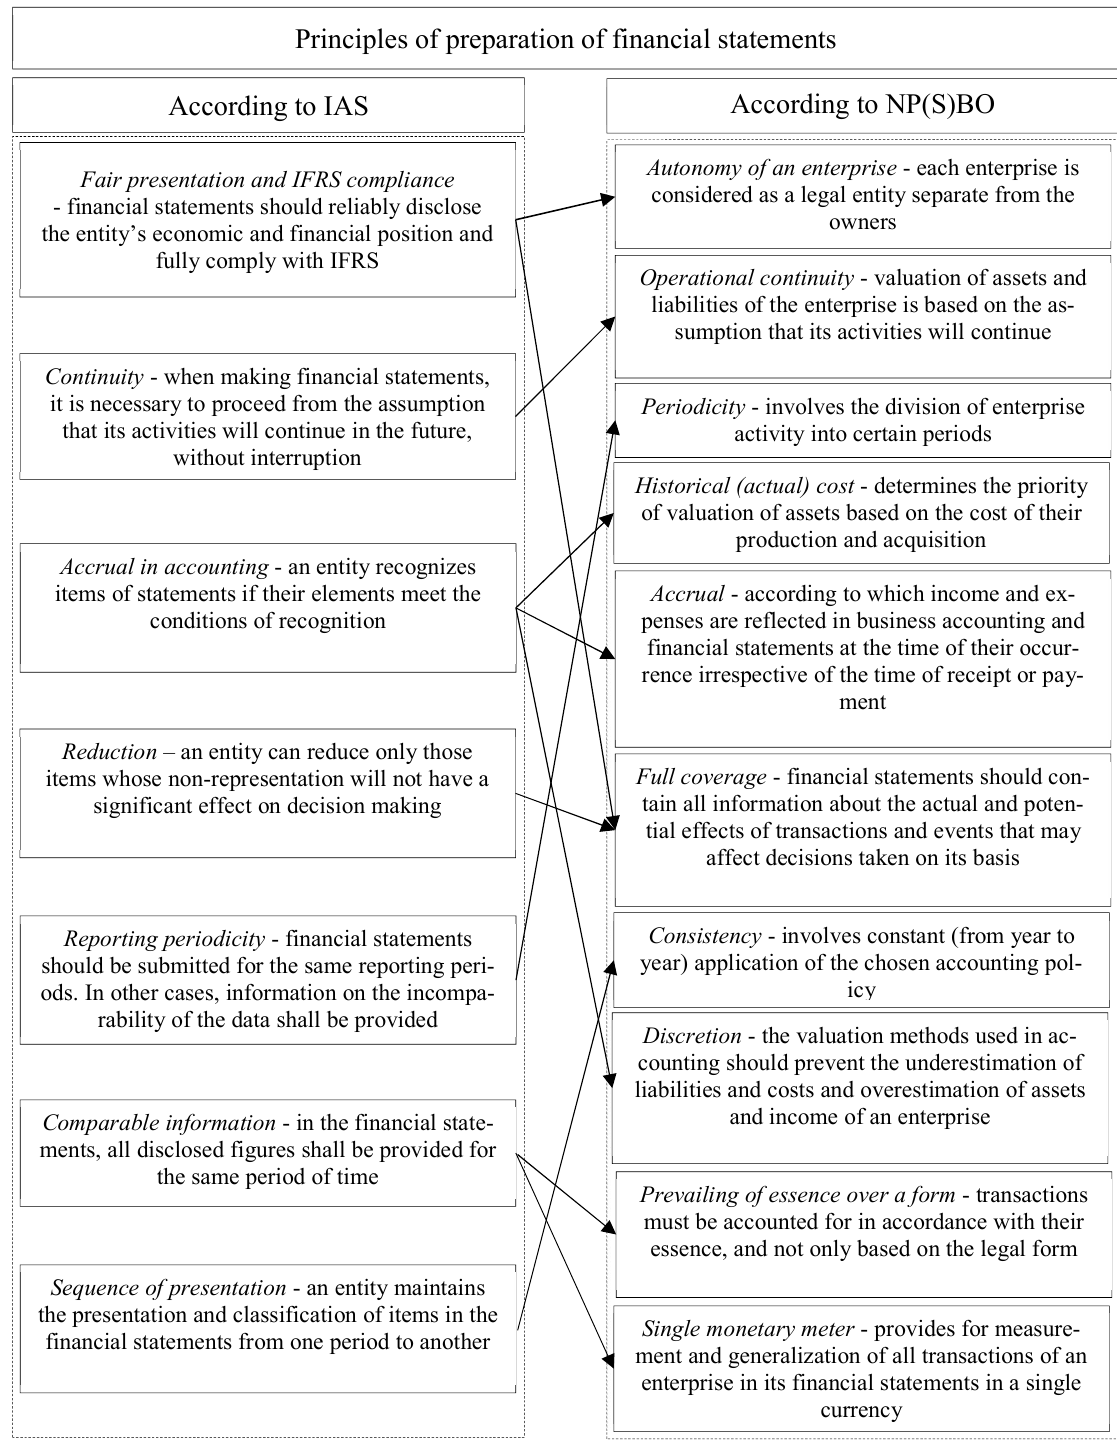
Fig. 3. Principles of preparation of financial